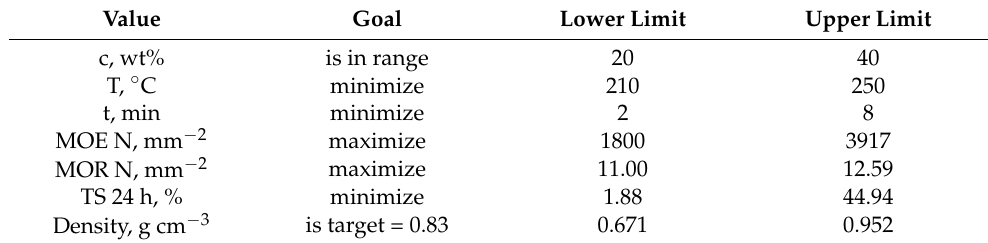
Table 10. Constraints for hot-pressing parameters and response values.